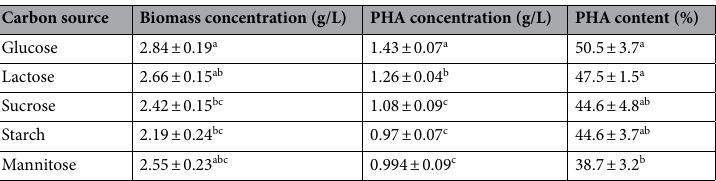
Table 3. Effect of carbon sources on the growth and PHA synthesis of Pichia sp. TSLS24. In a column, data with different superscript are significant with P < 0.05.